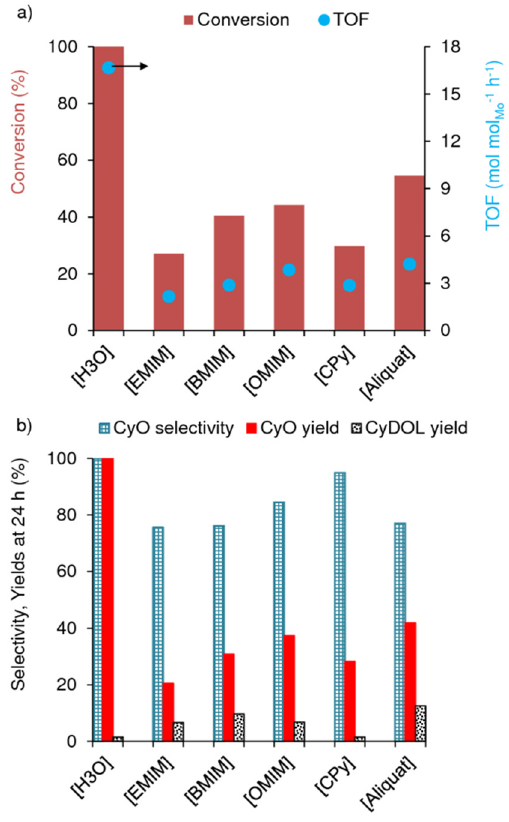
Figure 2. Catalytic epoxidation of Cy with TBHP, in the presence of [Cat][MoO(O 2 ) 2 (pic)] (only [Cat] is indicated in the abscissa axis for the sake of simplicity): ( a ) conversion of Cy at 24 h, and turnover frequency (TOF); ( b ) CyO selectivity, and yields of the epoxide (CyO) and corresponding diol by-product (CyDOL), at 24 h. Reaction conditions: 1 mol.% Mo, molar ratio TBHP:Cy = 1.6, TFT as solvent, 70 °C.